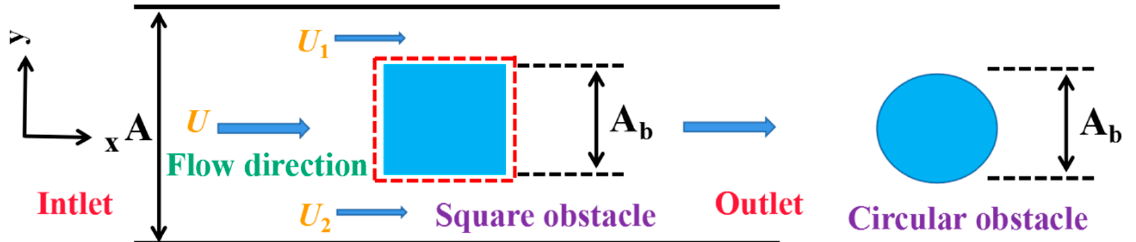
Figure 17. The distribution of obstacles in the microchannel.